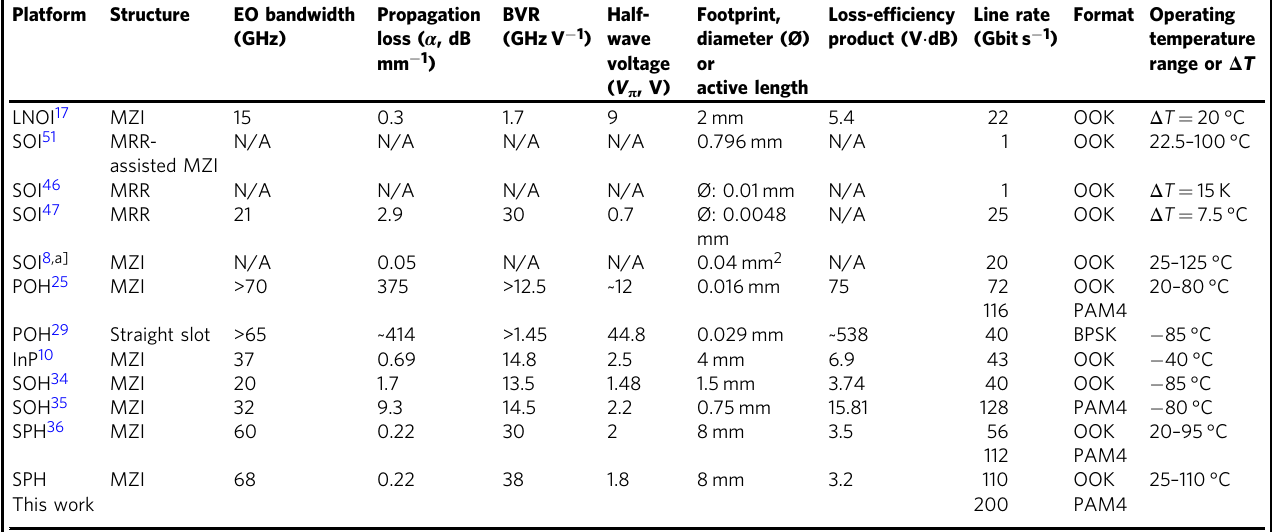
Table 1 Comparison of several metrics for EO modulators. Platform